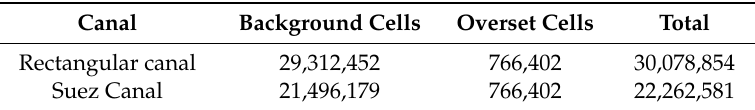
Table 3. Cell numbers for both canals.